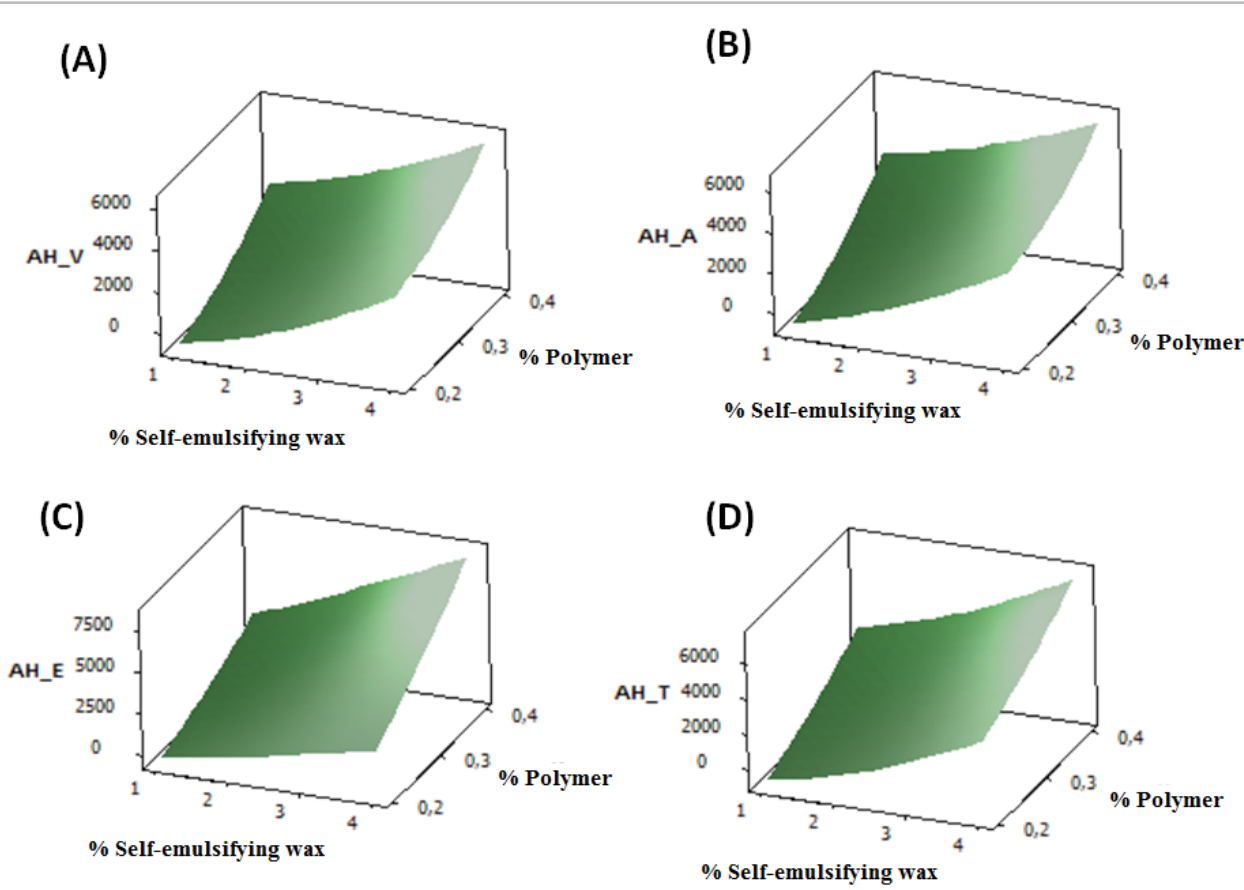
FIGURE 3 - Response surfaces for hysteresis area (AH) as a function of the factors: % of self-emulsifying wax and % hydrophilic polymer for the formulations: vehicle (A) containing 0.5% retinyl palmitate (B), 5% tocopheryl acetate (C) and 0.1% tocoretinate